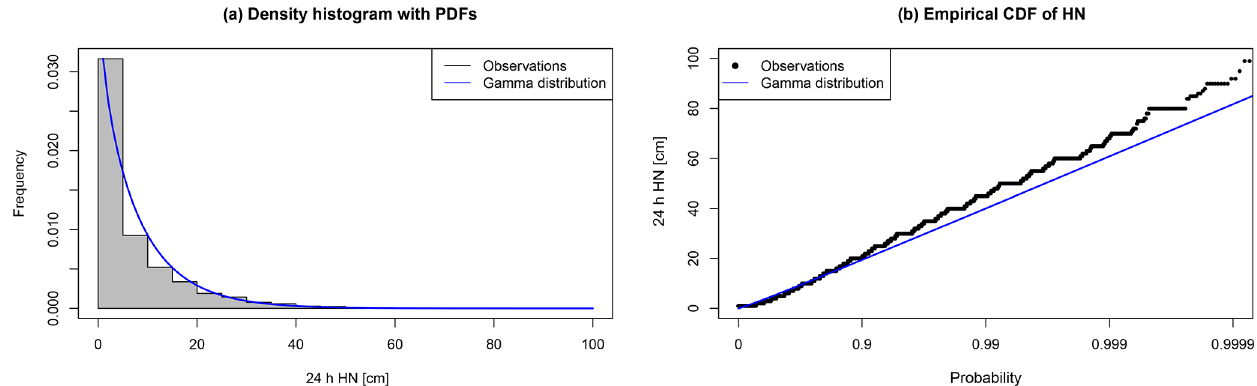
Figure 2. Distribution functions of positive HN observations over all dates and stations. (a) Frequency histogram of the raw data (grey) and probability density function of the fit with a gamma law (blue). (b) Cumulative distribution functions of observations (black) and gamma law (blue) with a focus on the distribution